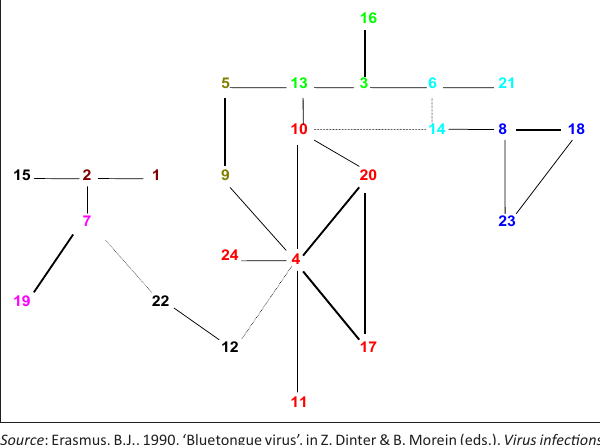
FIGURE 1: Serological cross-neutralisation of bluetongue virus